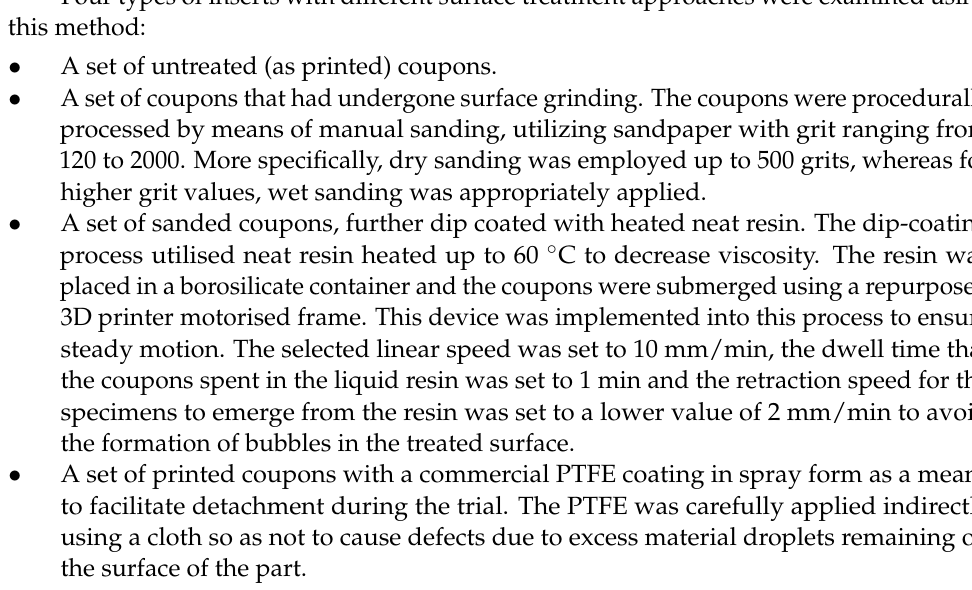
Figure 3. Positest At-A Defelsko Ata20 Adhesion tester.